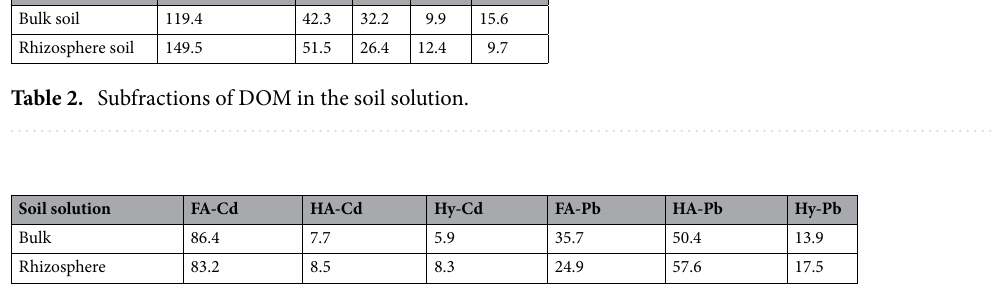
Table 3. Proportion of the subfractions of DOM complexed with Cd and Pb in soil solution (%).